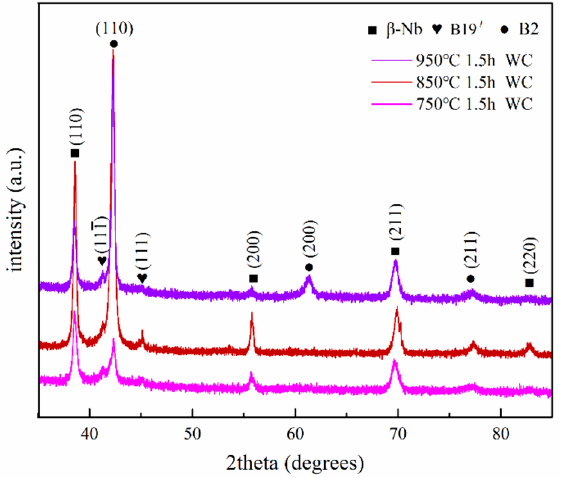
Figure 4. XRD patterns of Ni41Ti41Nb18 alloys after solution at 750 °C, 850 °C, and 950 °C in the state of reverse martensite transformation at room temperature.